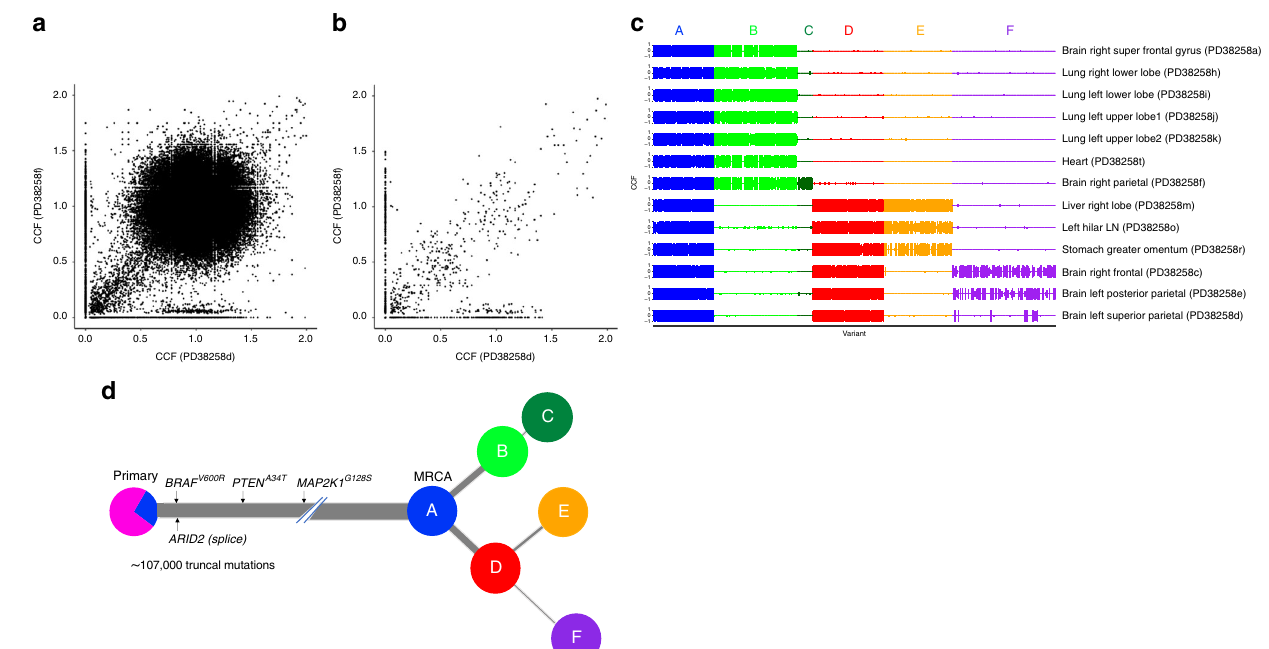
Fig. 2 Subtracting the clonal cluster revealed subclonal diversi fi cation in the index autopsy case. a Point estimates of the cancer cell fraction (CCF) are represented here as black dots across two representative samples in a density plot (left super parietal (PD38258d) and right parietal brain metastases (PD38258f), represented across the X and Y axes, respectively). We observed a large cluster of mutations at (1,1), corresponding to single nucleotide variants (SNVs) present in all the cells in both sites (CCF = 1), indicating truncal variants. b After removing the metastatic truncal variants, the metastatic non-truncal mutation clusters uncovered subclonal mutations. Although there are still a small number of SNVs at CCF 1, these did-not belong to the metastatic truncal cluster of mutations, representing those mutations found clonally in all metastases. c The clusters of metastatic non-truncal mutations are represented in a CCF distribution plot, wherein rows re fl ect samples and columns re fl ect alphabetically and colour-assigned mutation clusters ( n = 6). The x-axis represents the SNVs within each cluster and the y-axes represent CCF; the latter has been plotted in positive and negative directions for improved visualisation of clusters. d Alphabetically and colour-assigned mutation clusters from c are represented in circles, where branch length is proportionate to the number of SNVs in the cluster ( fi ltering SNVs occurring in regions with different CNA status across samples reduced 118,000 SNVs to 107,000 truncal SNVs indicated here) and branch thickness is proportionate to the average CCF of the cluster (across all the samples). Mutations that have occurred before the most recent common ancestor (MRCA) are carried by all tumour cells and de fi ne the metastatic truncal cluster of mutations. Truncal mutations in the melanoma driver genes BRAF V600R , PTEN A34T , MAPK2K1 G128S (the latter represents a mutation not previously reported in the COSMIC database 27 ) as well as an ARID2 splice-site variant are indicated on the trunk of the tree (the order of the driver mutations displayed on the trunk is arbitrary). The primary tumour colour shading represents the mutation clusters detected in the primary (using targeted sequencing), whereby the blue represents the subclonal mutation cluster within the primary (at average CCF of 0.27), which became fi xed and truncal across all